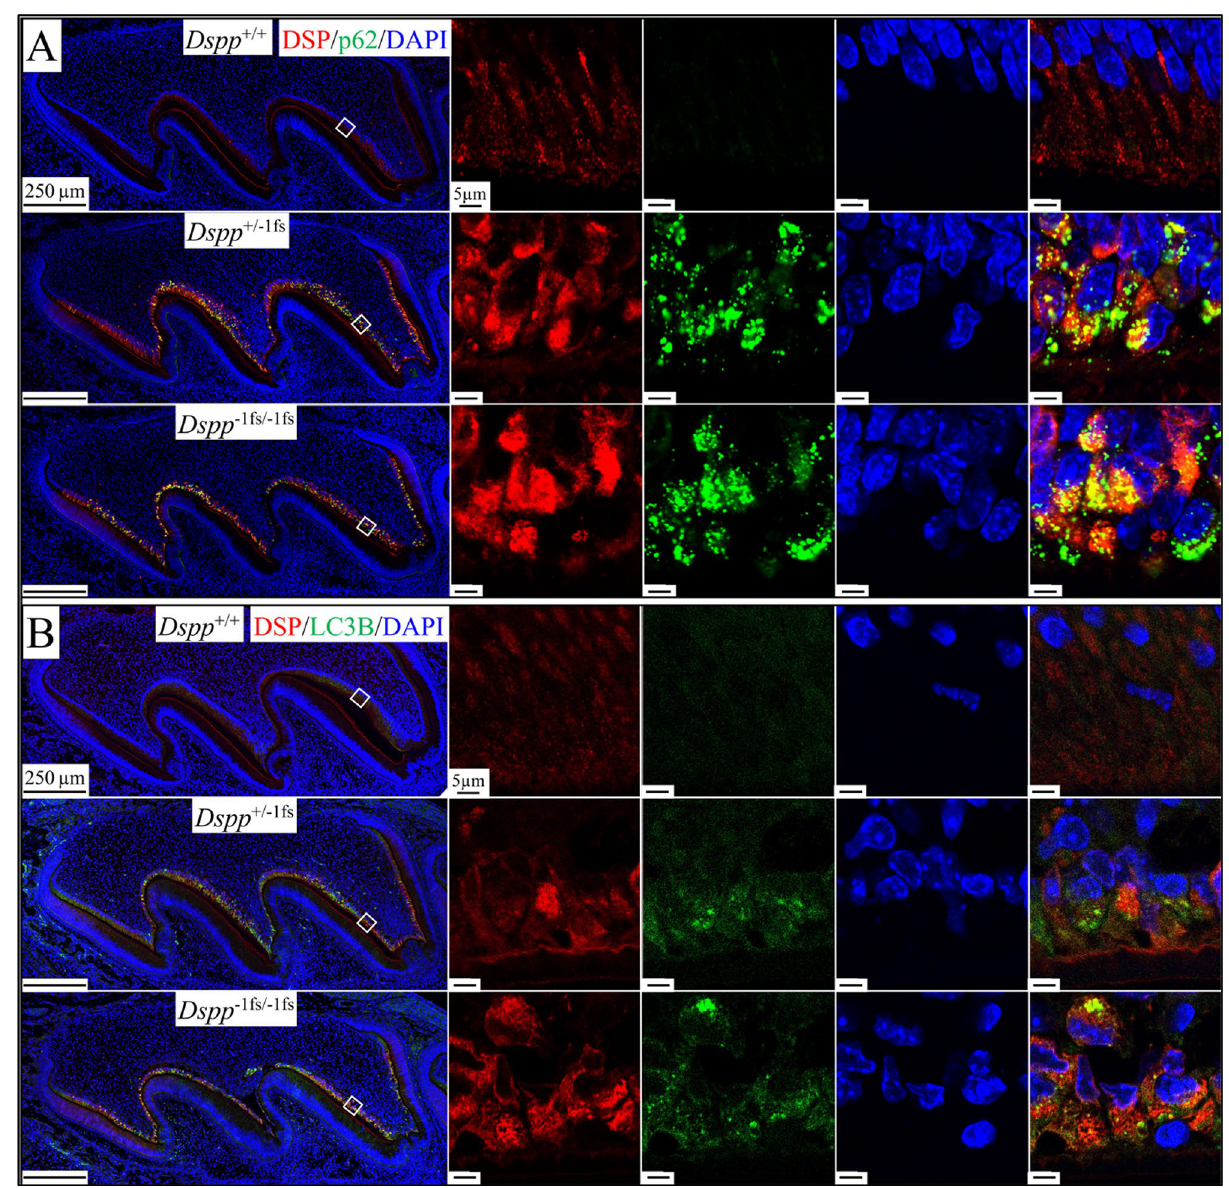
Figure 8. Autophagy is activated in the Dspp −1fs odontoblasts. Immunohistochemistry of D3 maxillary 1st molars, showing DSP (red), p62 (green in A; autophagy adaptor) or LC3B (green in B; autophagic vacuoles), and DAPI (blue; nucleus). ( A ) p62 signal was negative in Dspp +/+ odontoblasts and ameloblasts and in Dspp −1fs ameloblasts. Strong p62 signal was detected in Dspp −1fs odontoblasts. Most p62 signal colocalized with intracellular DSP, especially where DSP signal was at its highest. ( B ) LC3B signal was detected in Dspp +/+ odontoblasts at basal levels but were dramatically elevated in Dspp −1fs odontoblasts. Some LC3B signal colocalized with intracellular DSP signal. Scale bars: 250 μm (left)/5 μm (right). See also Figure